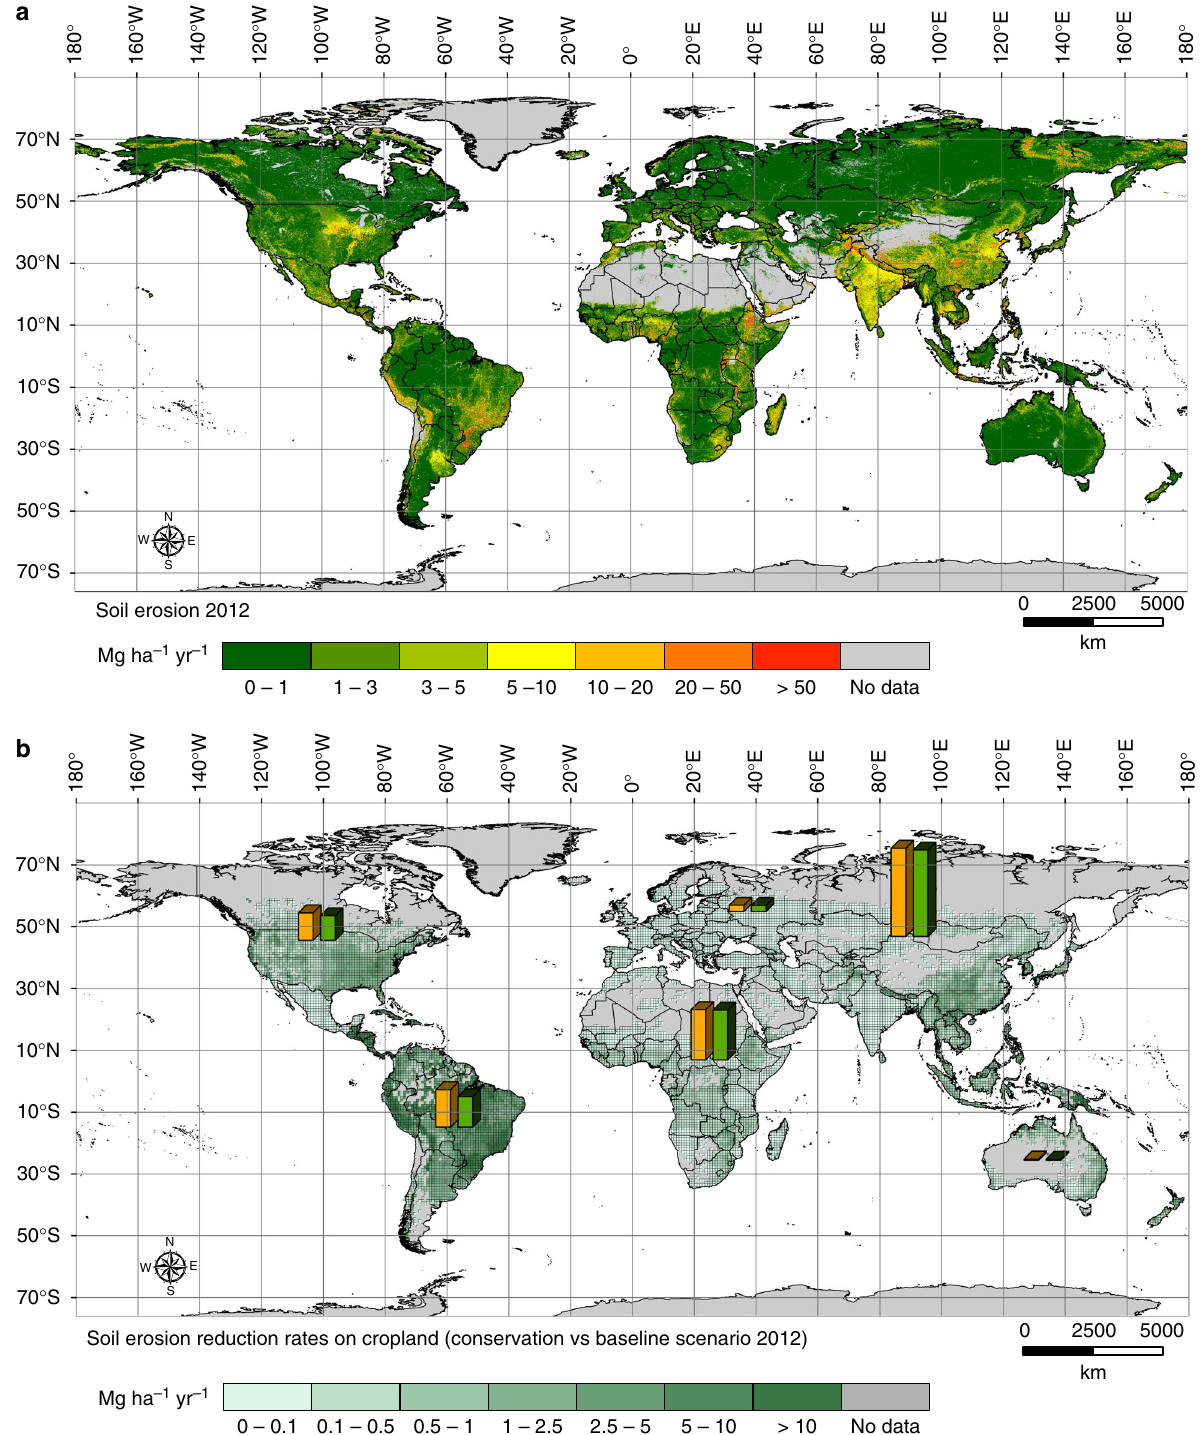
respectively. The remaining land surface (classes 5 – 7), about 7.5 million km 2 in total (6.1% of the land), exceeds the generic tolerable soil erosion threshold ( T -value) (10 Mg ha − 1 yr − 1 ) in 2012. Descriptive statistics about the severity of soil erosion across the continents in 2012 are provided in Table 1.